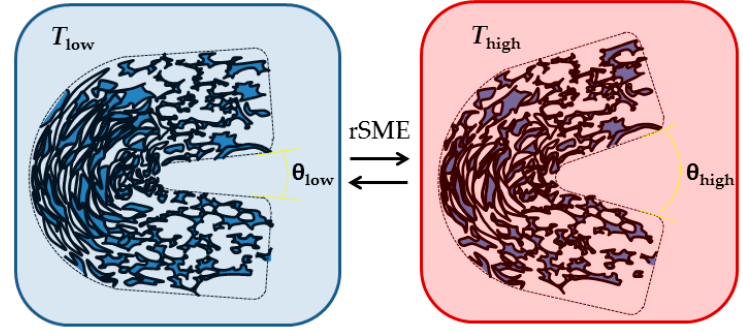
Figure 15. Scheme of rSME of semicrystalline water-blown foam. Figure 15 . Scheme of rSME of semicrystalline water-blown foam.